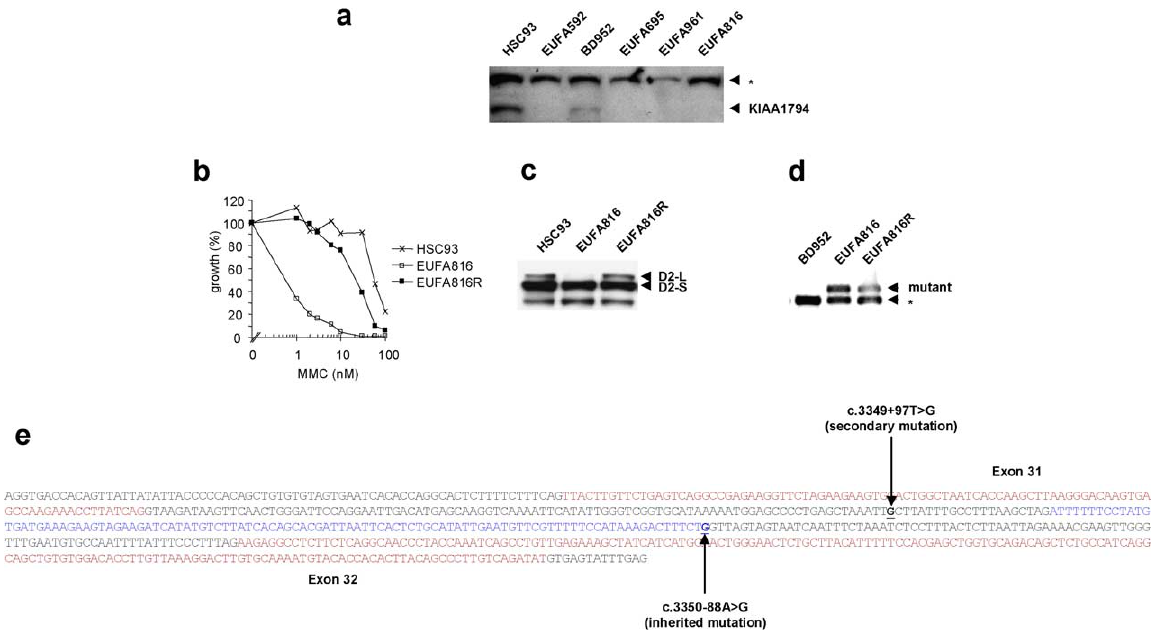
Fig. 2. Consequences of genomic sequence alterations at the KIAA1794 locus for the encoded protein and cellular phenotype. (a) Western blot showing absence of full-length KIAA1794 protein in extracts from lymphoblasts derived from FA-I individuals, except for individual BD952 carrying a missense mutation. HSC93, wild type lymphoblasts. The upper arrow head points to an aspecific band, which may serve as a loading control. According to molecular weight markers, the KIAA1794 protein band is at approximately 150 kDa. (b) Compensatory sequence alteration in KIAA1794 is associated with phenotypic reversion of FA-I lymphoblasts. A subline of lymphoblasts derived from patient EUFA816 was phenotypically reverted to mitomycin C (MMC) resistance (EUFA816R), as shown by MMC-induced growth inhibition curves; HSC93, wild type lymphoblasts. (c) Monoubiquitination of FANCD2 (formation of D2-L) is absent in EUFA816 lymphoblasts, but restored in the reverted cells. D2-S, non-ubiquitinated form of FANCD2. (d) Amplification of base pairs 3019 to 3765 of the KIAA1794 cDNA, encompassing exons 31 and 32, generated an extra (larger) fragment in EUFA816, which appeared weaker in the reverted cells, EUFA816R. Patient BD952 (who carries no mutations in the amplified region) served as a control. The lower band in EUFA816 cells (marked with asterisk) represents the other allele containing the premature stop mutation c.3853C>T in exon 37 (Table 2), whereas in the EUFA816R cells the lower band represents a mixture of the premature stop-containing allele and the wild type allele, due to an acquired secondary sequence alteration. (e) Genomic sequence showing exon 31 and 32 (red) and the additional exon (blue) resulting from the pathogenic mutation c.3350-88A>G (lower arrow) which creates a splice donor site with a score of 0.85 according to http://www.fruitfly.org/cgi-bin/seq_tools/splice.html. In EUFA816R cells a second mutation was observed (c.3349+97T>G, upper arrow), which reduces the splice acceptor score for the additional exon from 0.45 to 0.33, allowing the normal splicing to take place with a probability that appears sufficient to correct the cellular